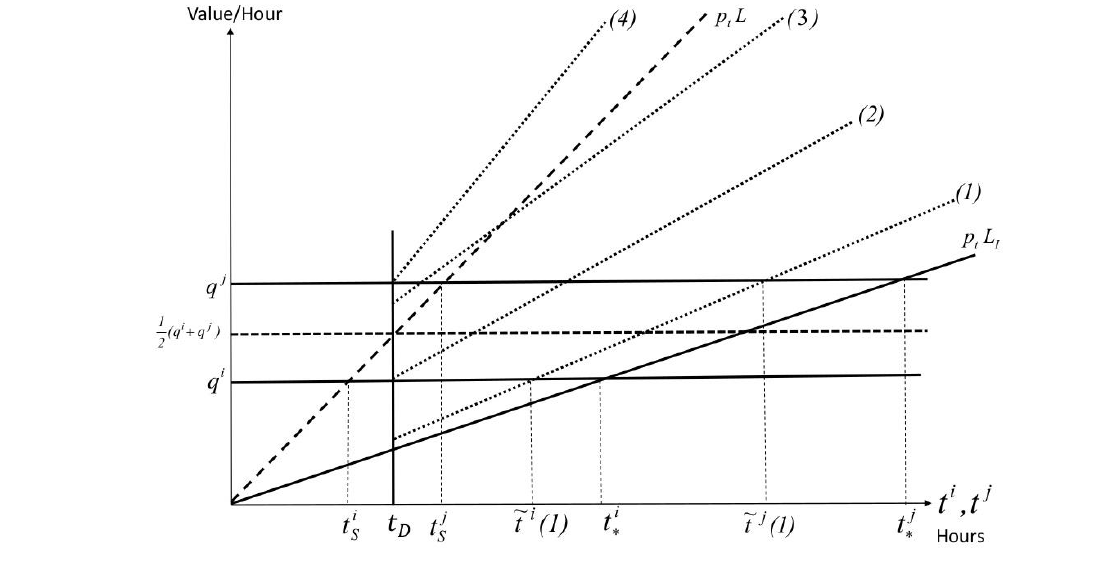
Figure 2. Consequences of time restriction enforced by various levels of public control effort. We consider two companies that differ only in marginal net revenue ( 𝑞 𝑖 < 𝑞 𝑗 ). The dotted curves, marked (1)-(4) illustrate the companies’ marginal expected costs (including marginal expected fine payment) for four different levels of control effort ( 𝑒 1 < 𝑒 2 < 𝑒 3 < 𝑒 4 , and where we assume that 𝑠 > 0). In cases with low level of resources in 𝑡𝑡 detection both companies find it advantageous to violate the rule. With a higher level of e, first company complies, and finally, as e is increased, both companies comply with the rule even though this leads to lower driving times than the first best